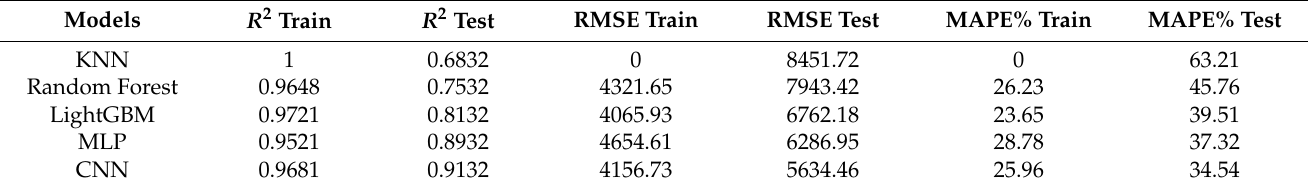
Table 3. Performance evaluation of developed